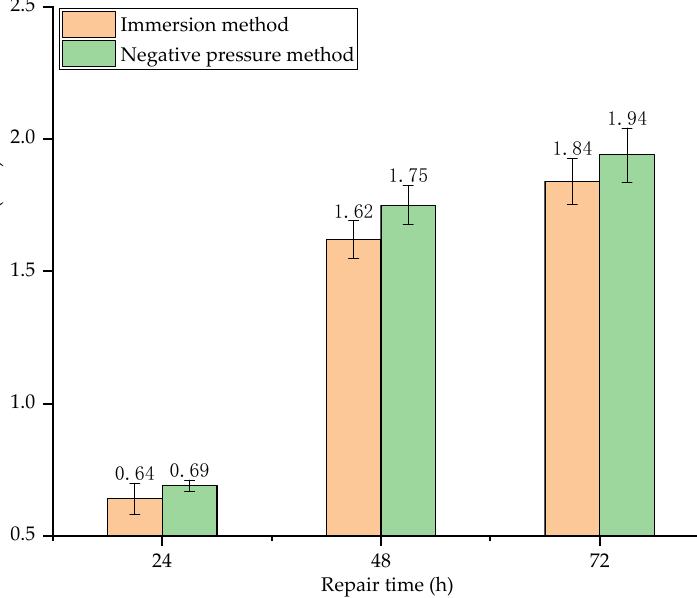
Figure 14. Surface film thickness of specimens repaired by different methods and for different repair time.